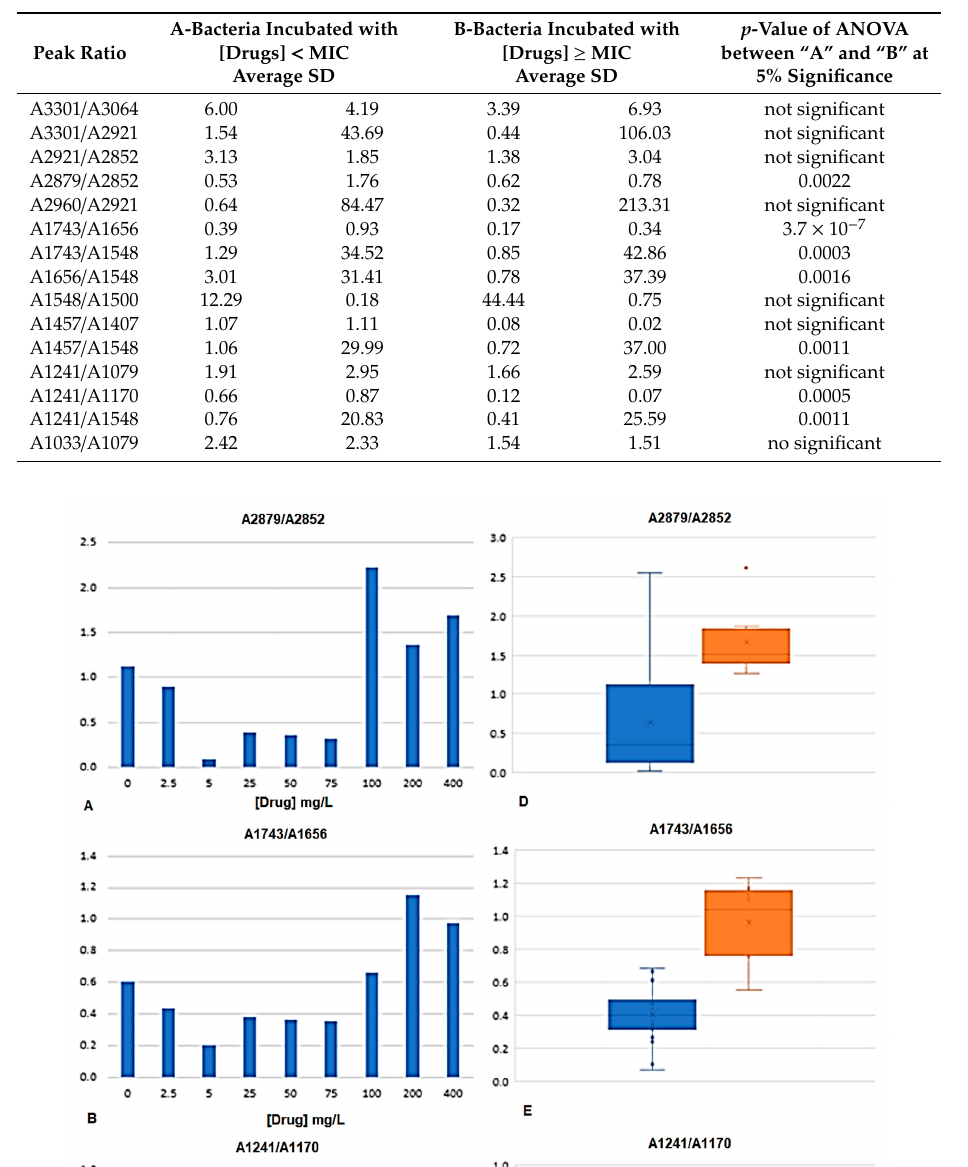
Table 3. Average values and standard deviation of ratios of peak heights from the bacteria spectra and the p -value from ANOVA between the incubation of 26,695 H. pylori with concentrations of the peptide-based drug lower than the MIC and bacteria incubated with drugs concentrations higher or equal to the MIC.